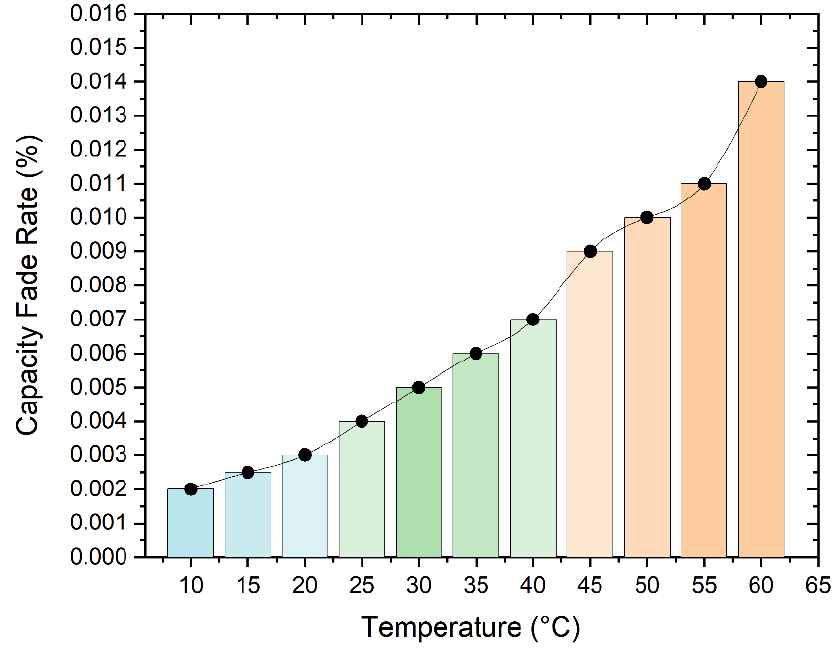
Figure 11. Characteristic cycle aging battery [31].